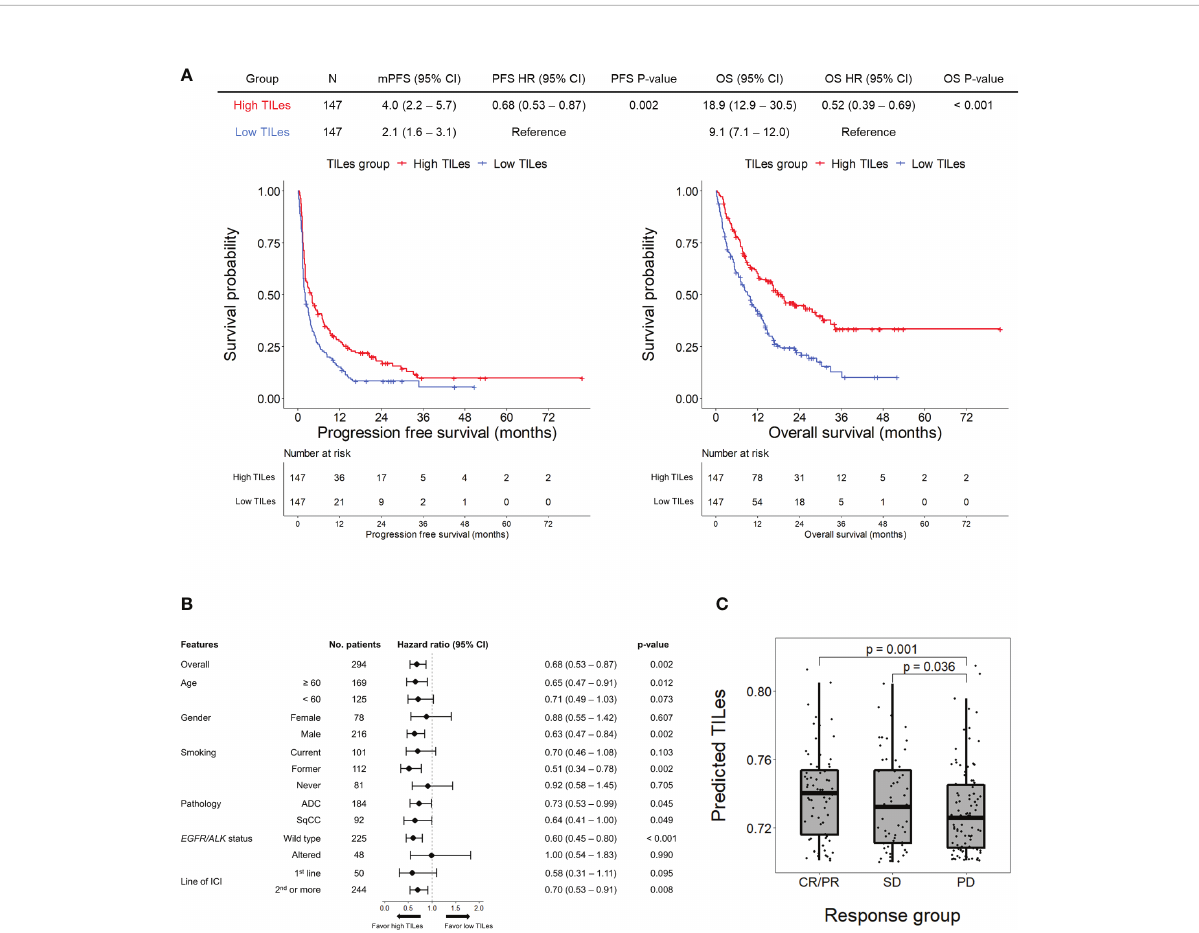
FIGURE 3 Outcomes of patients receiving immune checkpoint inhibitors (ICI) according to predicted TILes in the validation cohort (A) The upper table summarizes the survival analyses of the patients. The left Kaplan-Meier curves show progression free survival (PFS) and the right Kaplan-Meier curves show overall survival (OS) according to the predicted tumor in fi ltrating lymphocyte enrichment score (TILes) group. The red line represents the high TILes and the blue line represents the low TILes groups. The censored data are marked with vertical lines. The numbers at risk are provided below. (B) Forest plot for subgroup analysis of PFS according to predicted TILes in the validation cohort (C) The boxplot showing predicted TILes according to the response to ICI. Each dot represents each